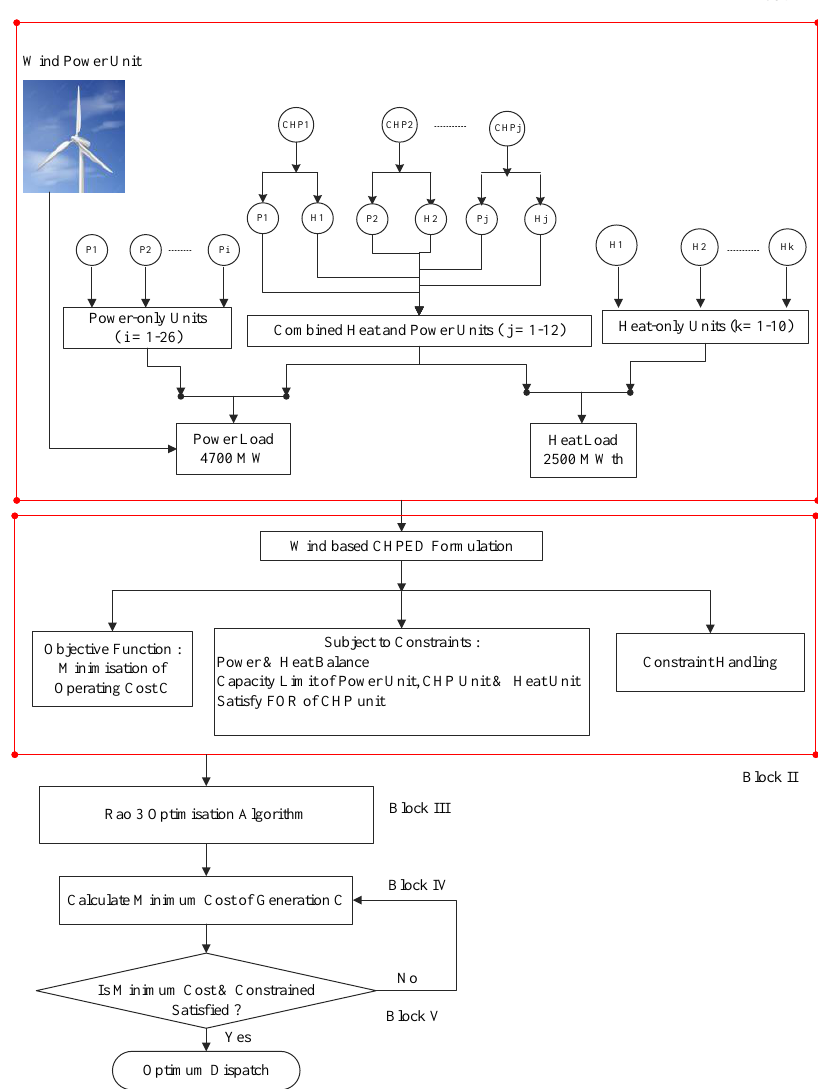
Figure 2. Block diagram of wind-based CHPED system.